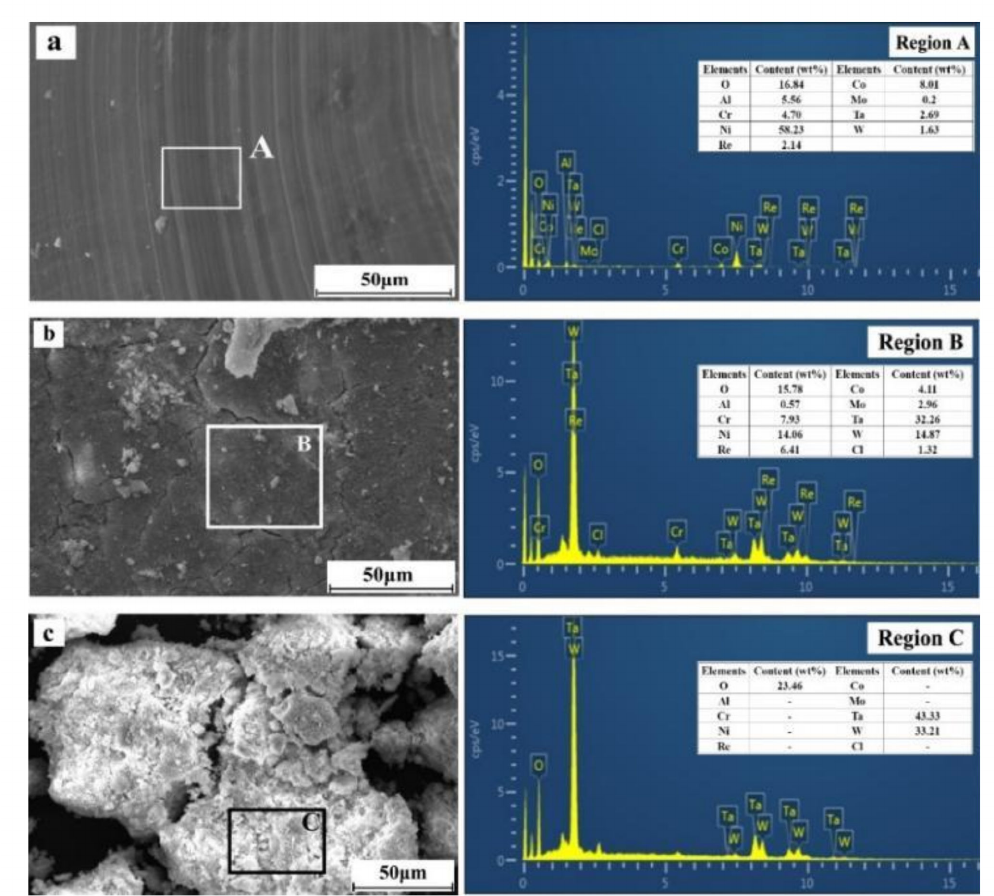
Figure 8. SEM and EDS analyses of the superalloy scraps and leaching residues (( a )—superalloy scraps; ( b )—conventional leaching residues; ( c )—ultrasonic leaching